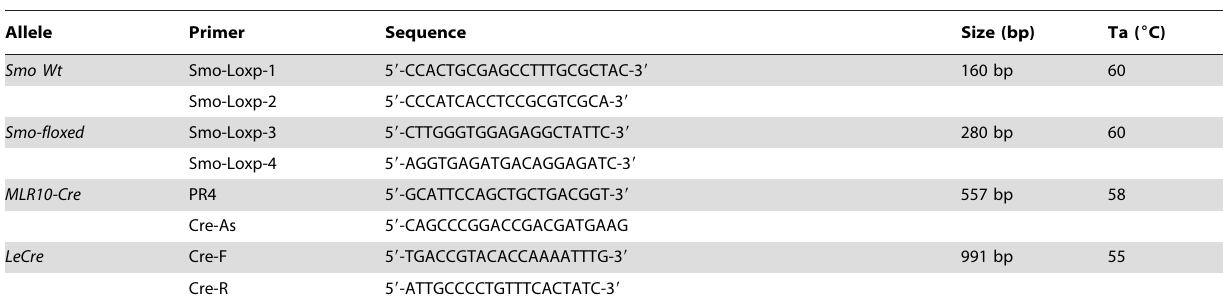
Table 1. Genotyping Primers.